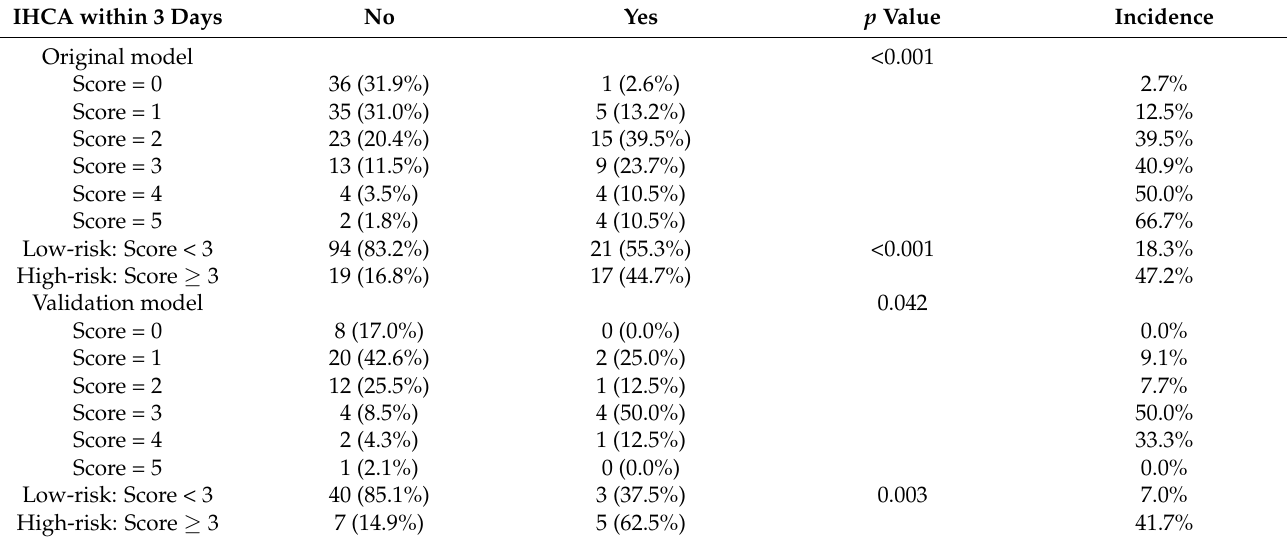
Table 5. The prediction score system and validation for the incidence of in-hospital cardiac arrest (IHCA). IHCA within 3